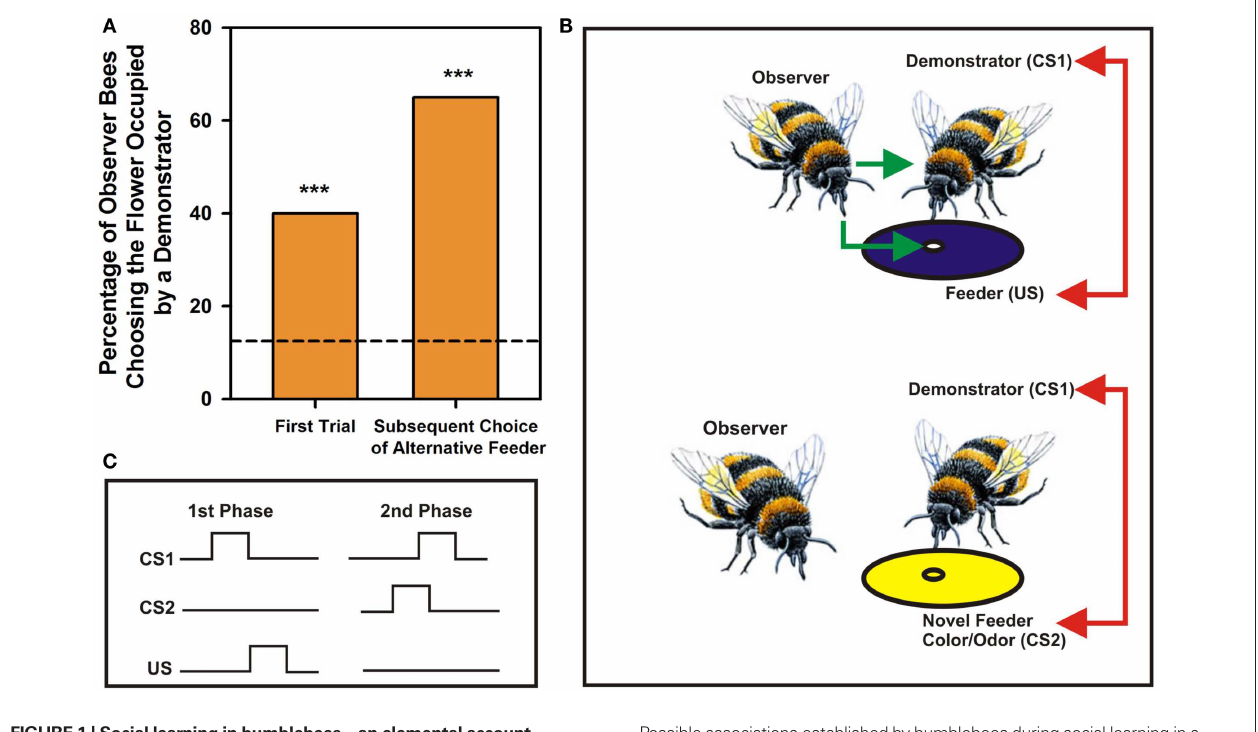
Figure 1 | Social learning in bumblebees – an elemental account. (A) Percentage of choices by observer bees of a feeder occupied by a demonstrator bee. The arena contained eight feeders, four blue and four yellow. The demonstrator was placed on one feeder type, yellow or blue, and the observer released in the arena. Right bar: Choices of the feeder occupied by a demonstrator in the first trial, when both feeder types were unfamiliar to observers. Left bar: Choices of the alternative feeder type in subsequent trials when it was occupied by a demonstrator. The dashed line corresponds to a random choice in a situation where eight feeders were available. Asterisks correspond to p < 0.01. Adapted from Leadbeater and Chittka (2005). (B)